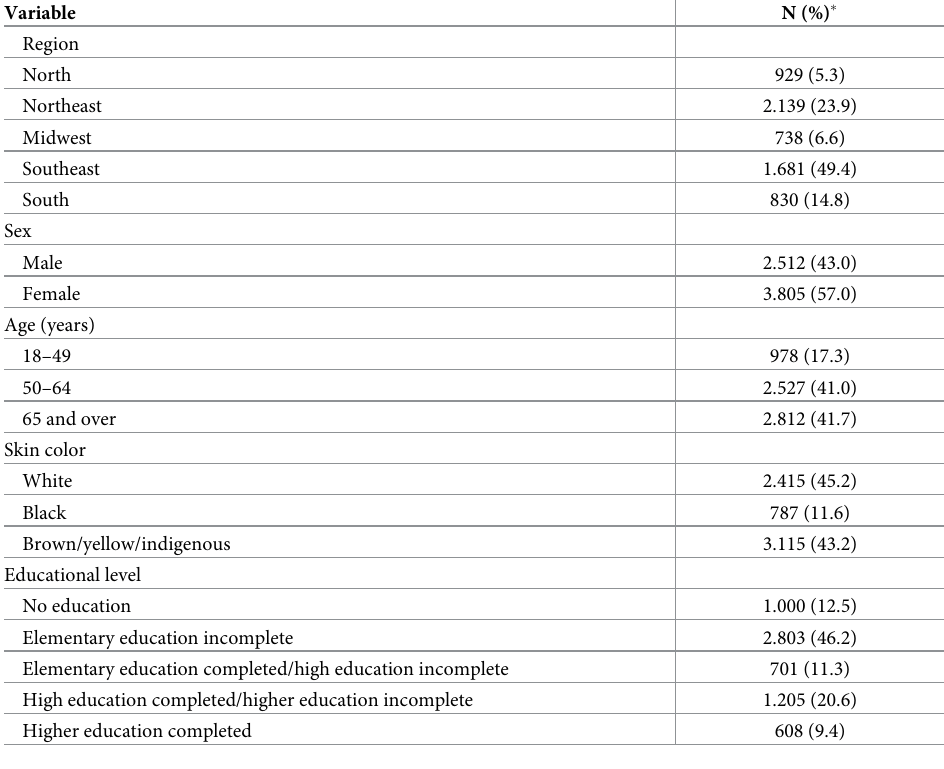
Table 1. Description of the sample according to regional and sociodemographic characteristics in the people with diabetes mellitus, Brazil, 2019 (N =